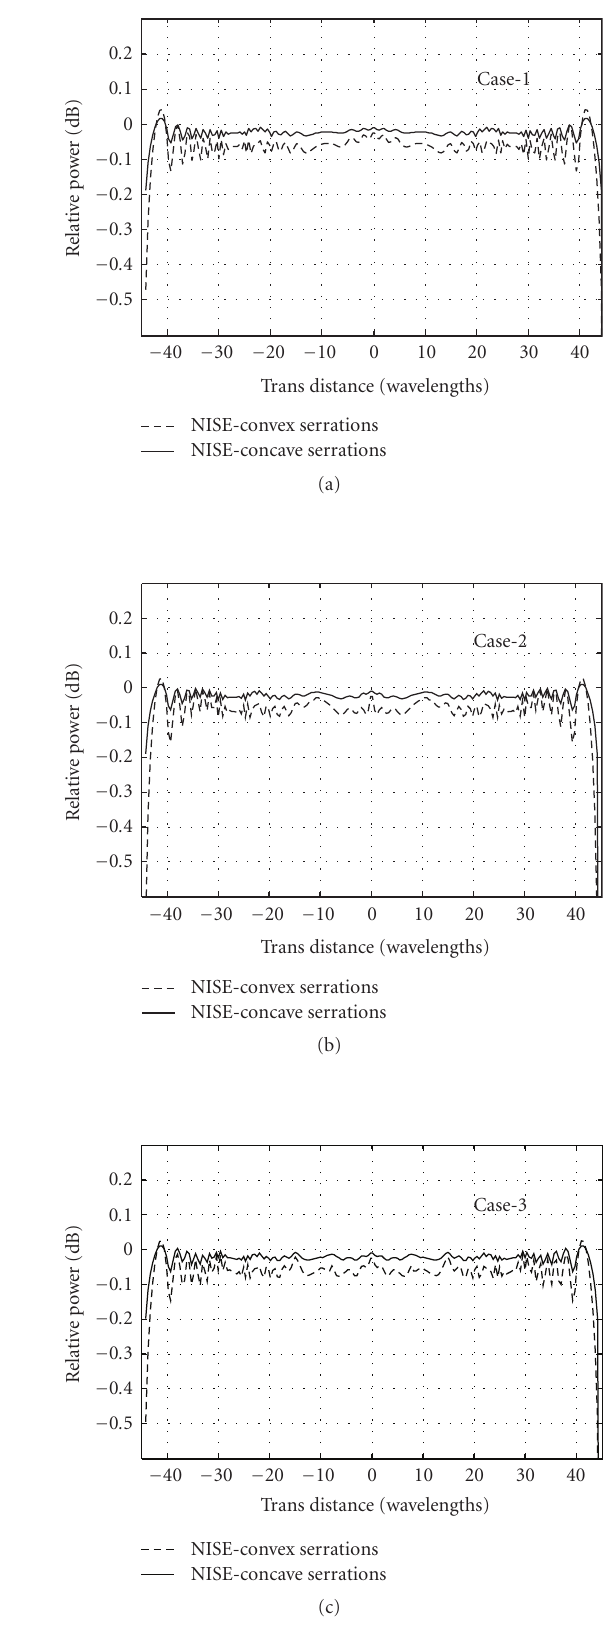
Figure 5: Fresnel-zone field for 90 λ × 90 λ NISE-convex and NISE- concave serrated CATRs for cases 1, 2, and